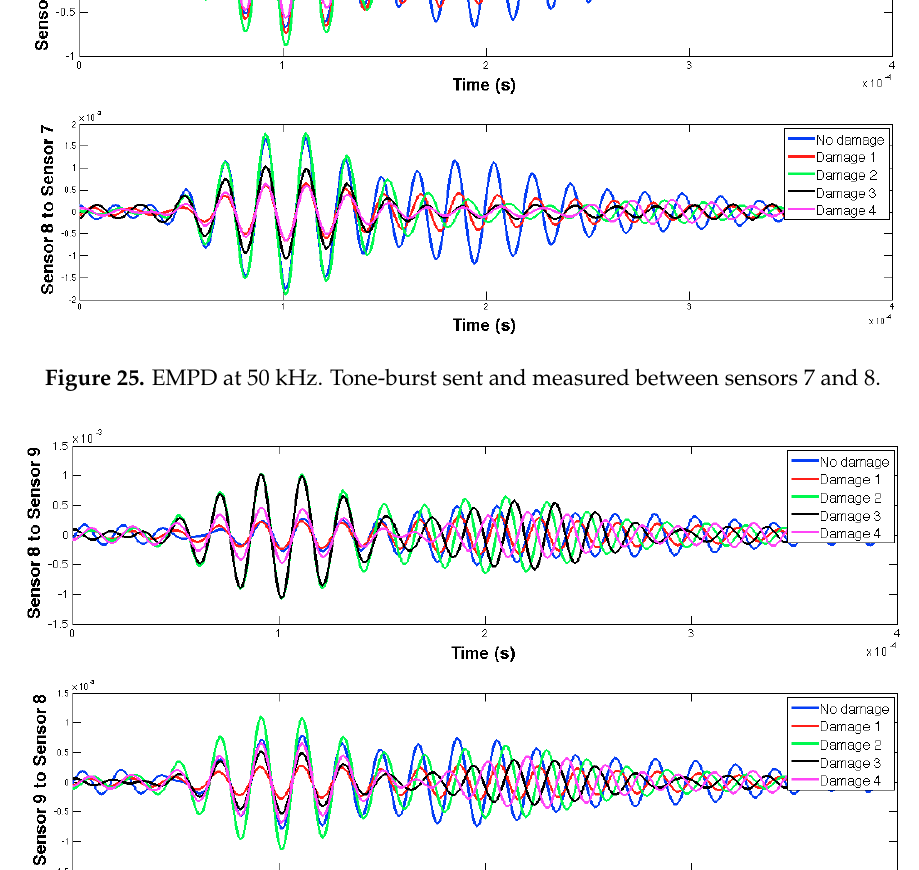
Figure 26. EMPD at 50 kHz. Tone-burst sent and measured between sensors 8 and 9.